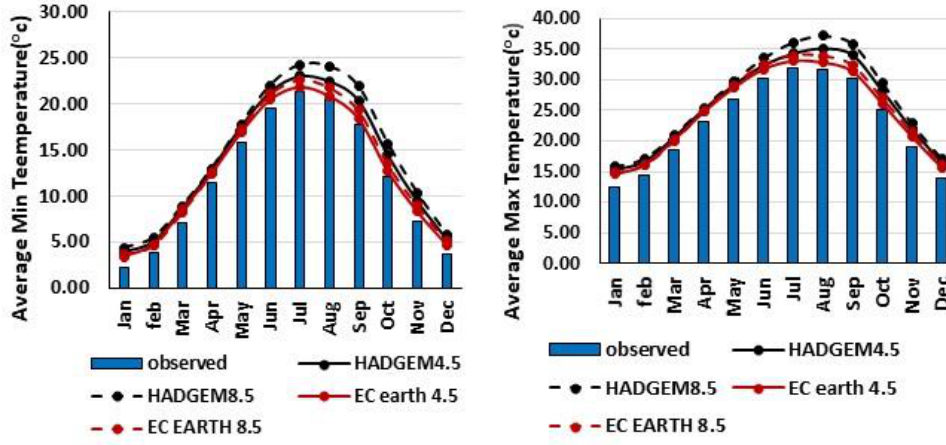
Figure 5. Average monthly maximum and minimum temperatures for climate scenarios: RCP 4.5 and RCP 8.5 of GCM models: HadGEM2 and EC-Earth along with observed monthly maximum and minimum temperature.